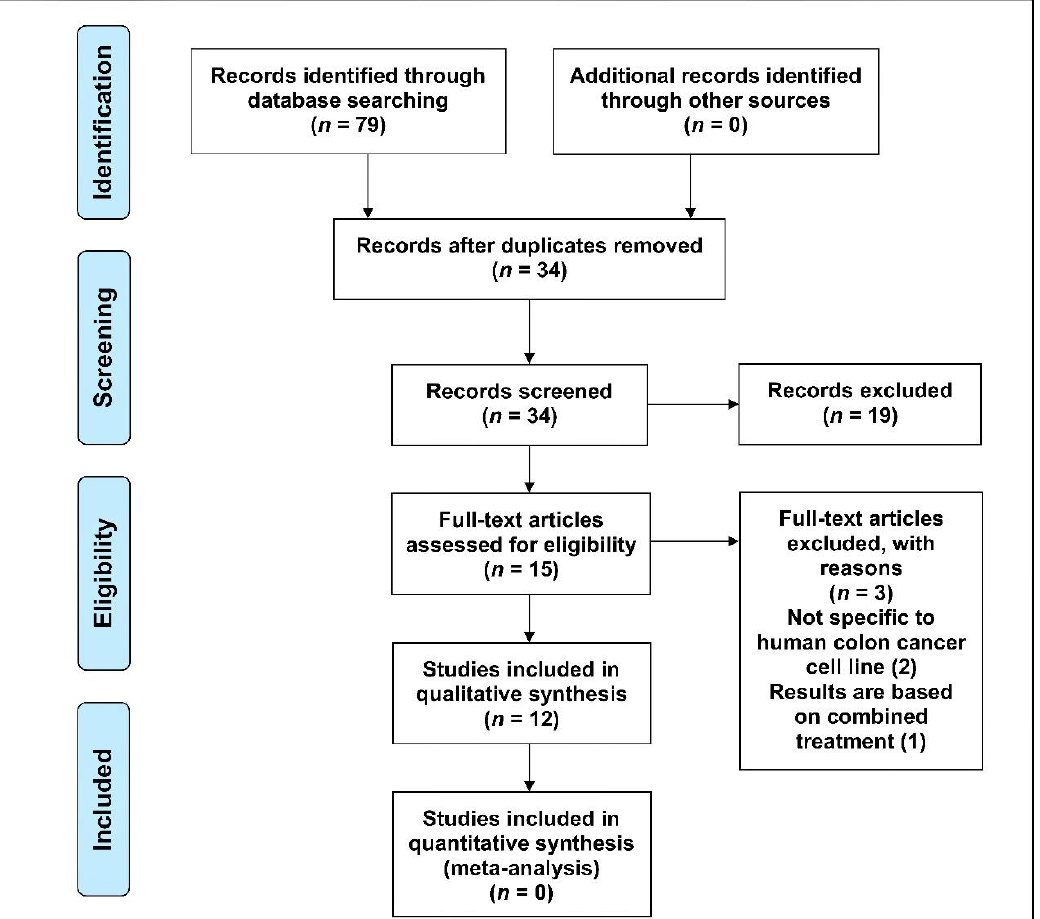
Figure 2. Research articles were searched on four databases (Ovid MEDLINE, PubMed, Scopus, and Embase) that reported using the preferred reporting items for systematic reviews (PRISMA) flow chart.